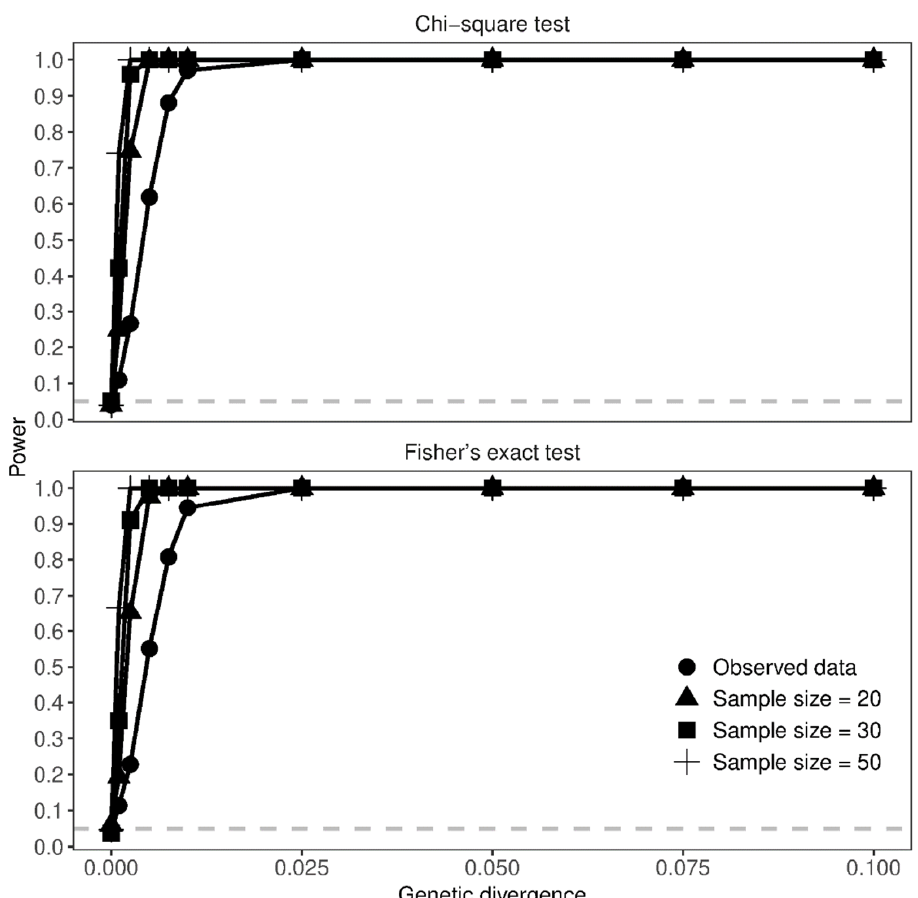
Figure 3. Sample size effect on the power of detecting population differentiation in isolated populations. Different G ’ ST values (x-axis) were obtained by increasing the number of generations since the split of populations, whereas population effective size and migration were constant ( N e = 1000 and m = 0, respectively). The proportion of significant tests over 1000 simulated data for each scenario (y-axis) corresponds to α -error when G ’ ST = 0 and to power otherwise. The gray-dashed line outlines the threshold of the expected α -error ( α = 0.05).